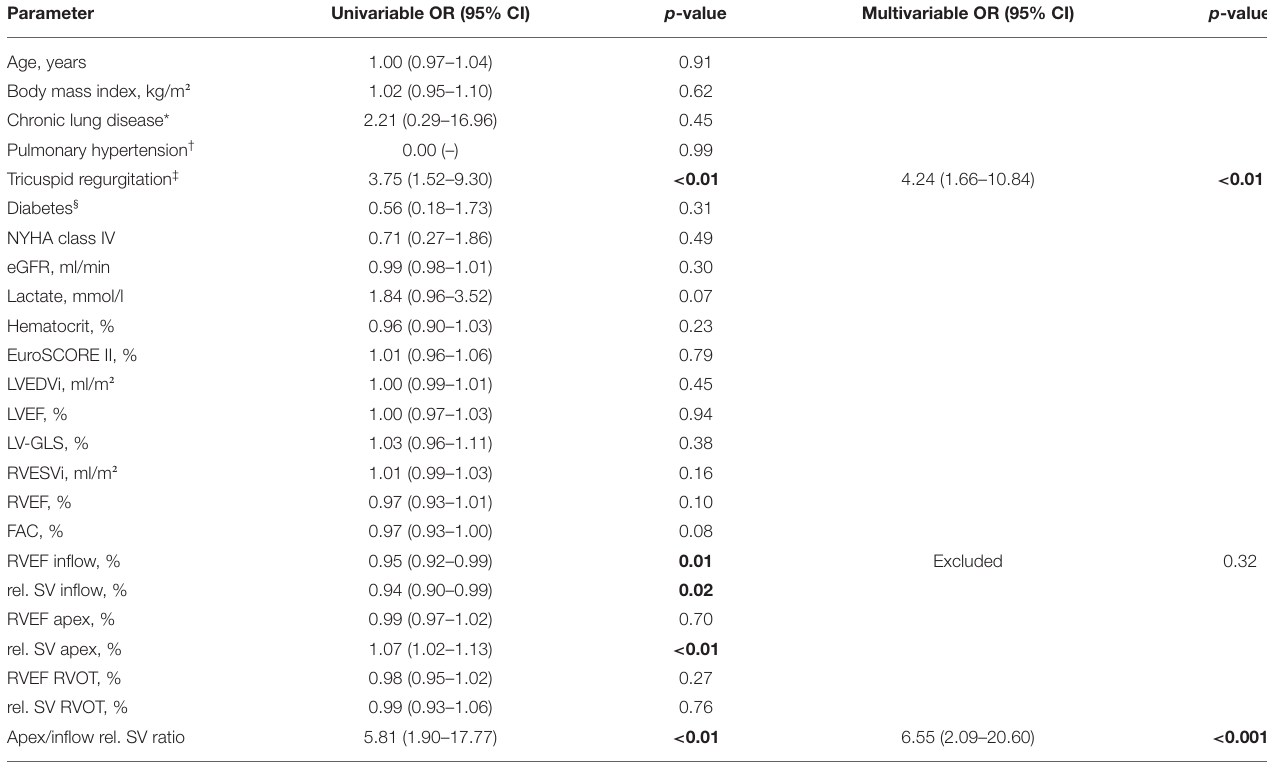
TABLE 3 | Univariable and multivariable logistic regression analysis for the association with the endpoint (in-hospital mortality or the need for ECLS). Parameter